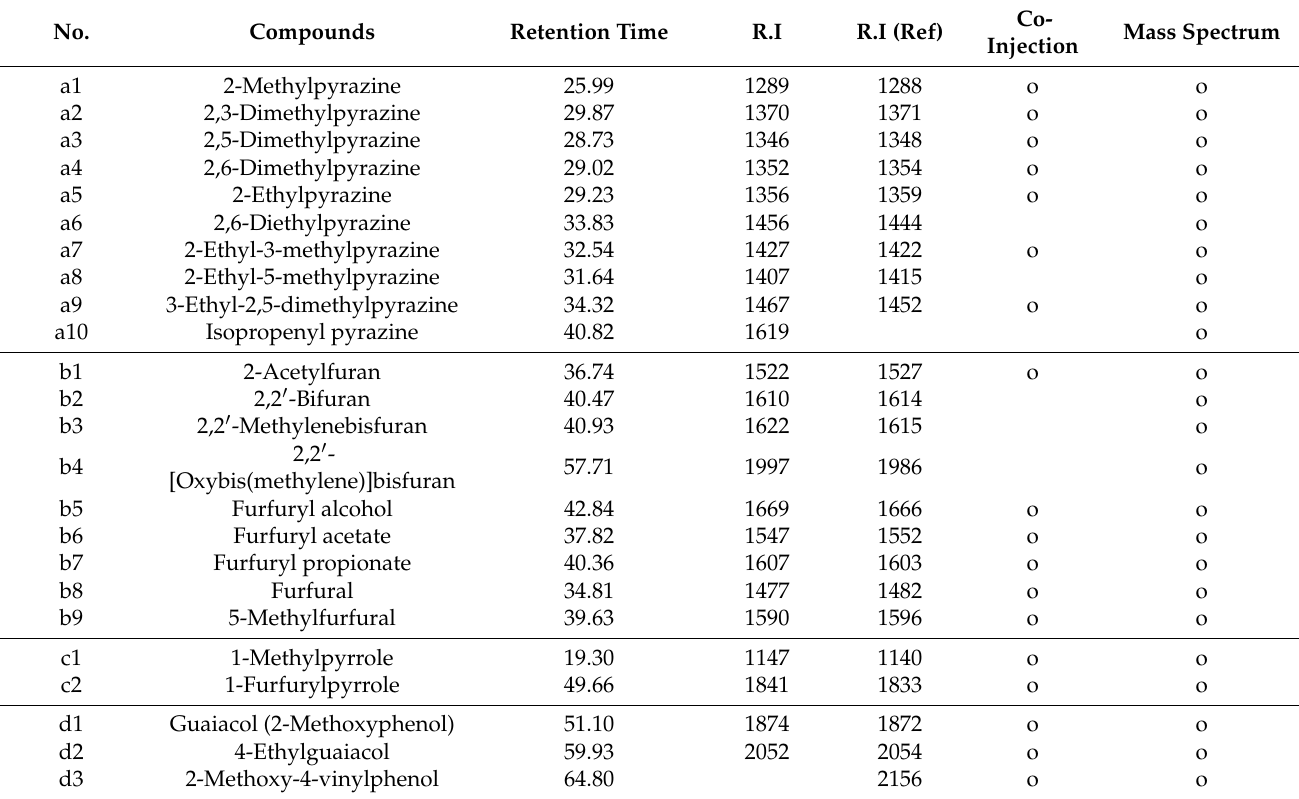
Table 1. Volatile compounds in coffee (E-1: espresso brewing method, roasted at 235 ◦ C for 13 min, particle size of ground coffee bean 355 µ m, and purified